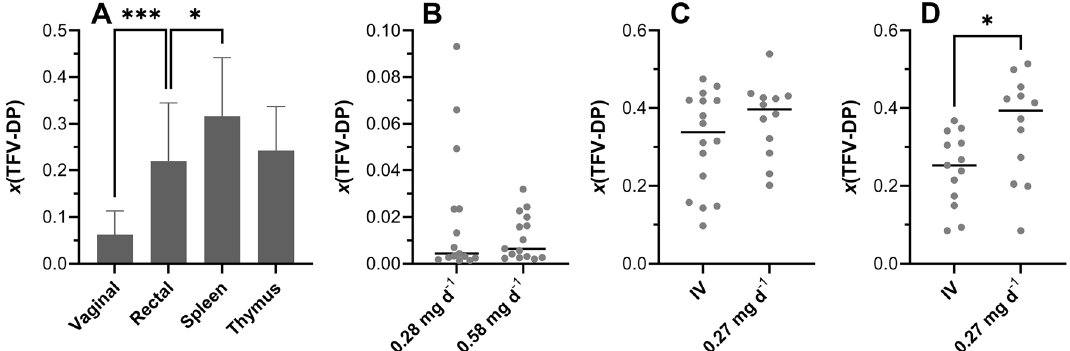
Figure 6. Tissue homogenate TFV-DP mole fractions, x (TFV-DP), and mole fraction distributions are different across anatomic compartments following TAF administration (IV and implant) in C57BL/6 J mice. ( A ) IV TAF dosing study; a Kruskal–Wallis test (unpaired, nonparametric) was used to compare all four groups and found that the x (TFV-DP) values were significantly different ( P < 0.0001). The vaginal versus rectal ( P = 0.0001, ***) TFV-DP mole fractions and the spleen versus rectal ( P = 0.0468, *) TFV-DP mole fractions were found to be significantly different using a Mann–Whitney t -test (unpaired, nonparametric). The thymus versus spleen ( P = 0.0755) and thymus versus rectal ( P = 0.6501) TFV-DP mole fractions were found to be not significantly different using the same t -test. ( B ) Scatter plot showing distributions of dermal x (TFV-DP) values for low- (0.28 mg d -1 in vivo) and high- (0.58 mg d -1 in vivo) releasing TAF implant groups; circles represent individual measurements/animals and horizontal lines represent medians. The data were not found to be significantly different ( P = 0.9349) using a Mann–Whitney t -test. ( C ) Scatter plot showing distributions of spleen x (TFV-DP) values for IV dosing and low- (0.27 mg d -1 in vivo) releasing TAF implant groups; circles represent individual measurements/animals and horizontal lines represent medians. The data were not found to be significantly different ( P = 0.2803) using a Mann–Whitney t -test. ( D ) Scatter plot showing distributions of thymus x (TFV-DP) values for IV dosing and low- (0.27 mg d -1 in vivo) releasing TAF implant groups; circles represent individual measurements/animals and horizontal lines represent medians. The data were found to be significantly different ( P = 0.0257) using a Mann–Whitney t -test.